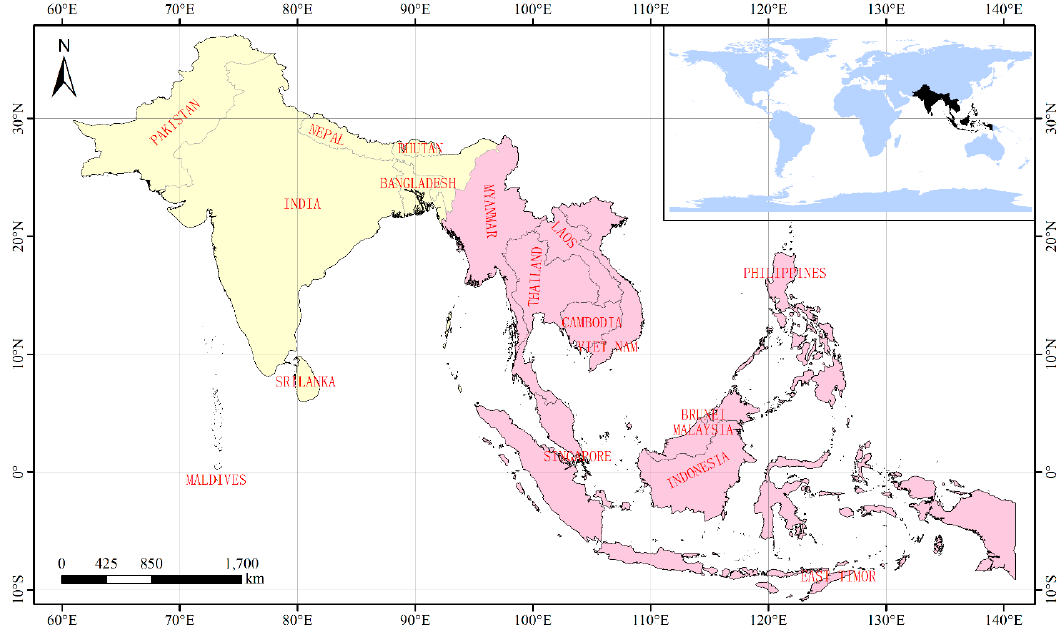
Figure 1. Area: South Asia (light yellow region) and Southeast Asia (light pink region).